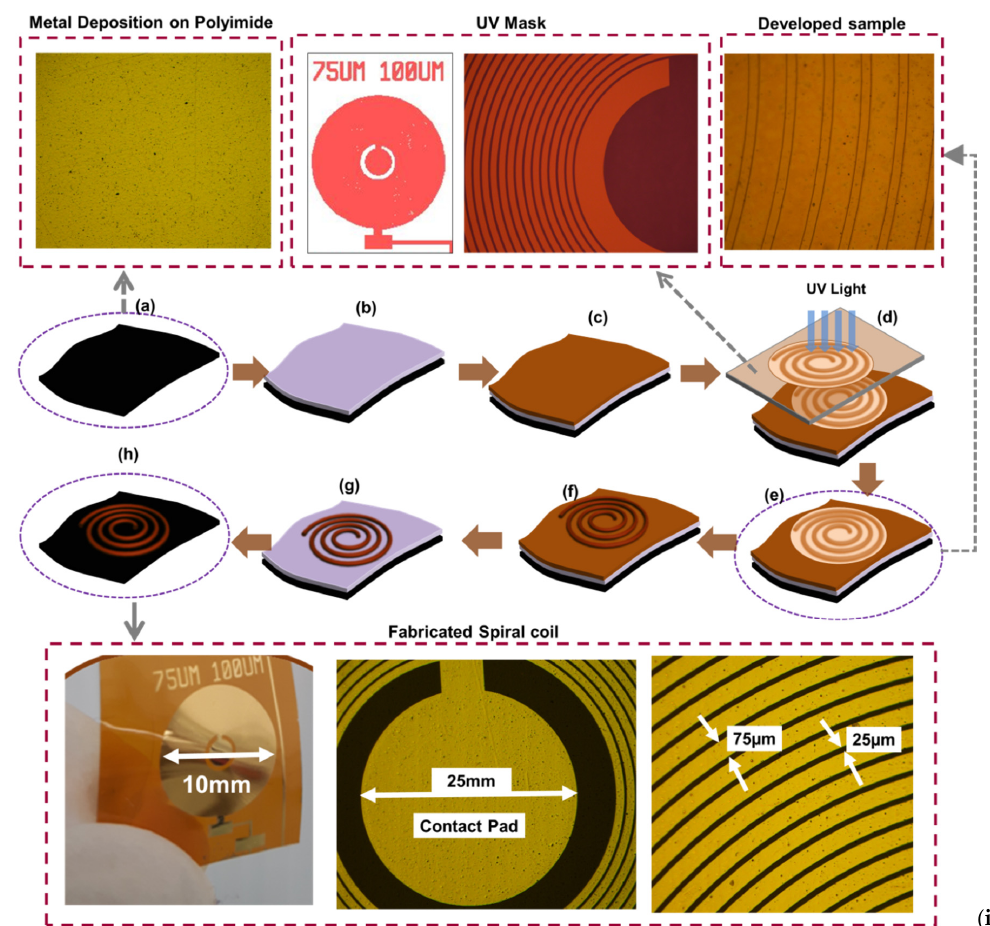
Figure 3. Fabrication steps for realization of the coil: ( a ) Initial flexible substrate; ( b ) Gold deposition; ( c ) Spin-coating of photoresist; ( d ) Exposure of photoresist; ( e ) Developing the photoresist; ( f ) Electroplating the coil; ( g ) lift-off the photoresist; ( h ) Etching of the seed layer; and ( i ) Fabricated Coil.